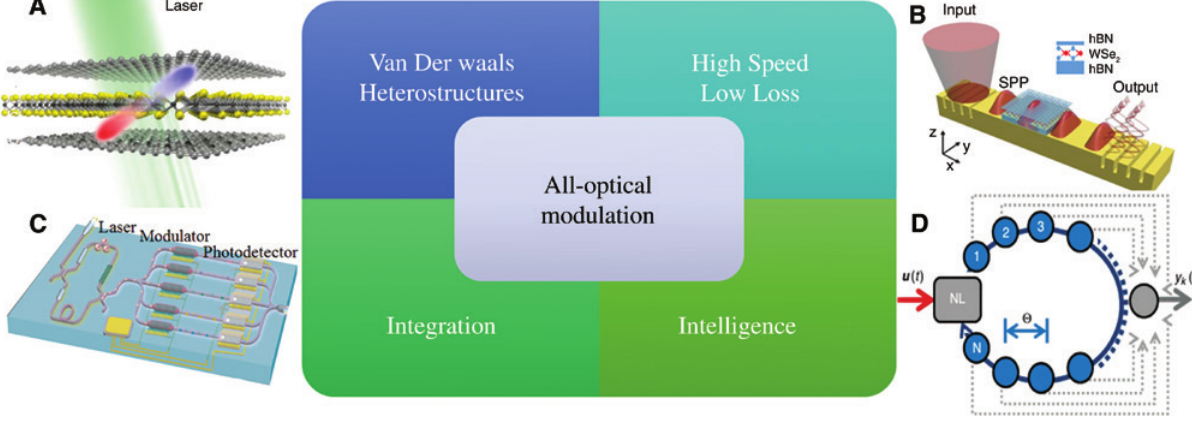
Figure 8: Promising development directions of all-optical modulation with 2D layered materials. (A) Schematic of heterostructures consisting of different kinds of 2D layered materials [166]. (B) Diagram of ultrafast modulators enabled by interaction between surface plasmon polaritons and excitons in 2D materials [167]. (C) Schematic illustration of integrated 2D material- silicon hybrid photonic circuit [165]. (D) Schematic illustration of computation using nonlinear transient states generated by a single nonlinear element subject to delayed feedback [168]. (A) Reproduced with permission [166]. Copyright 2016, Nature Publication Group. (B) Reproduced with permission [167]. Copyright 2019, Nature Publication Group. (C) Reproduced with permission [165]. Copyright